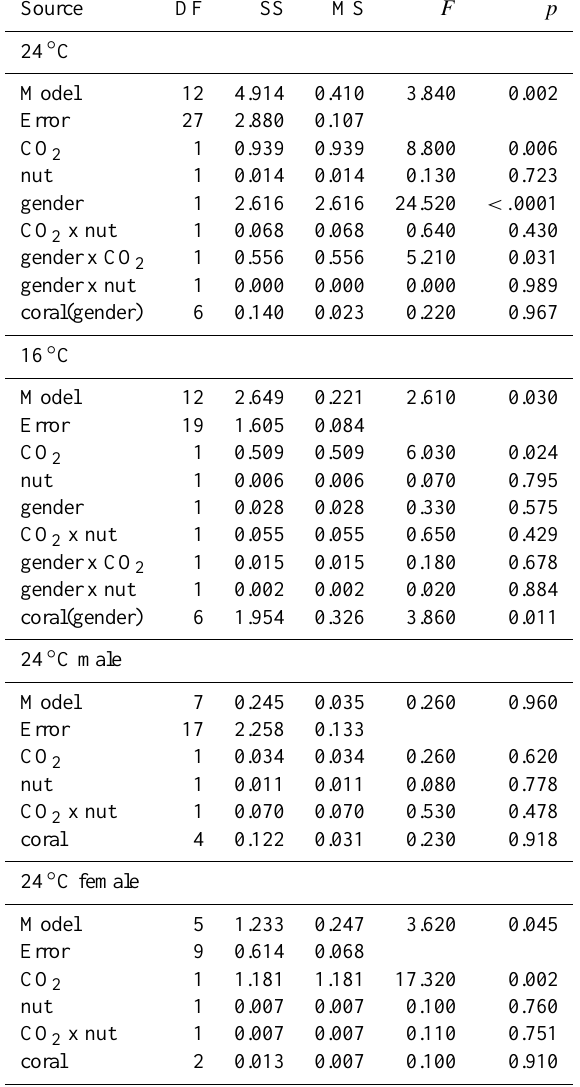
Table 3. ANOVA results for the effects of CO 2 , nutrients (nut), gender and interaction there of on the change in relative calcifica- tion rates, with the source coral colony (coral) nested within gender. Due to a significant CO 2 x gender interaction at 24 ◦ C, the 24 ◦ C data were then tested for the effects of CO 2 , nutrients, and their in- teraction on each gender separately. Since there was a significant effect of CO 2 for female corals at 24 ◦ C, Dunnetts HSU test was used determine which treatments differed from ambient – CO 2 only was significant p = 0 . 025. Data for zooxanthellate and azooxan- thellate corals have been pooled.